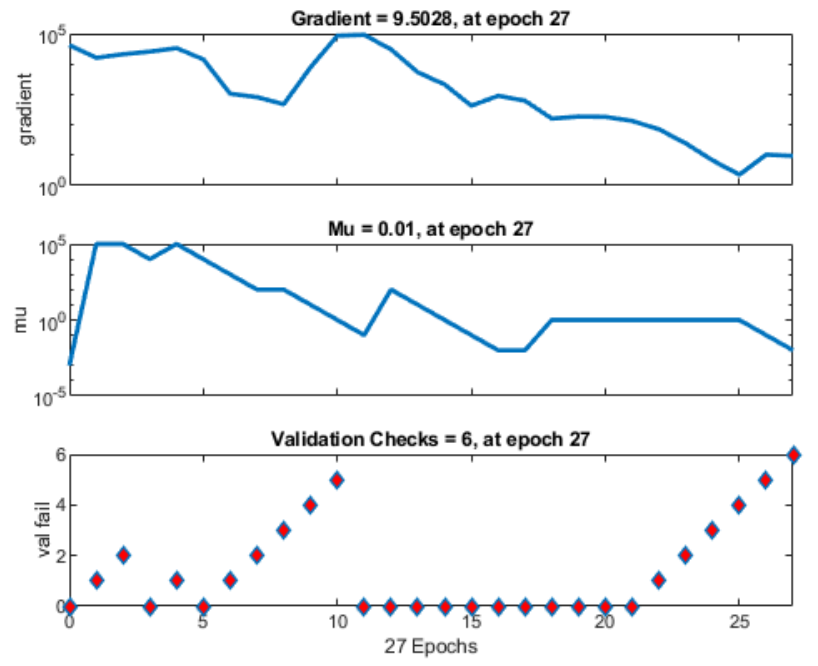
Figure 27. Training state of neural model identification.